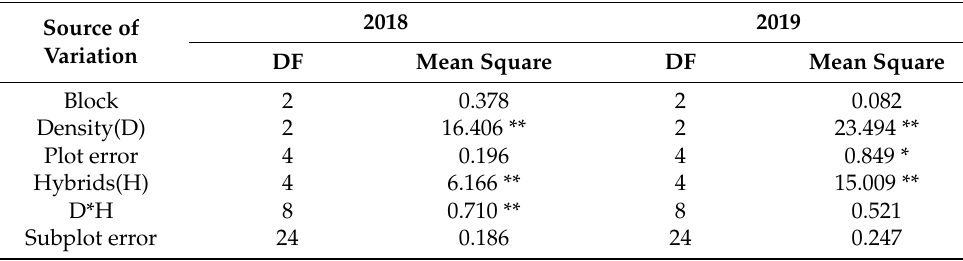
Table 3. Variance analysis of grain water content at physiological maturity